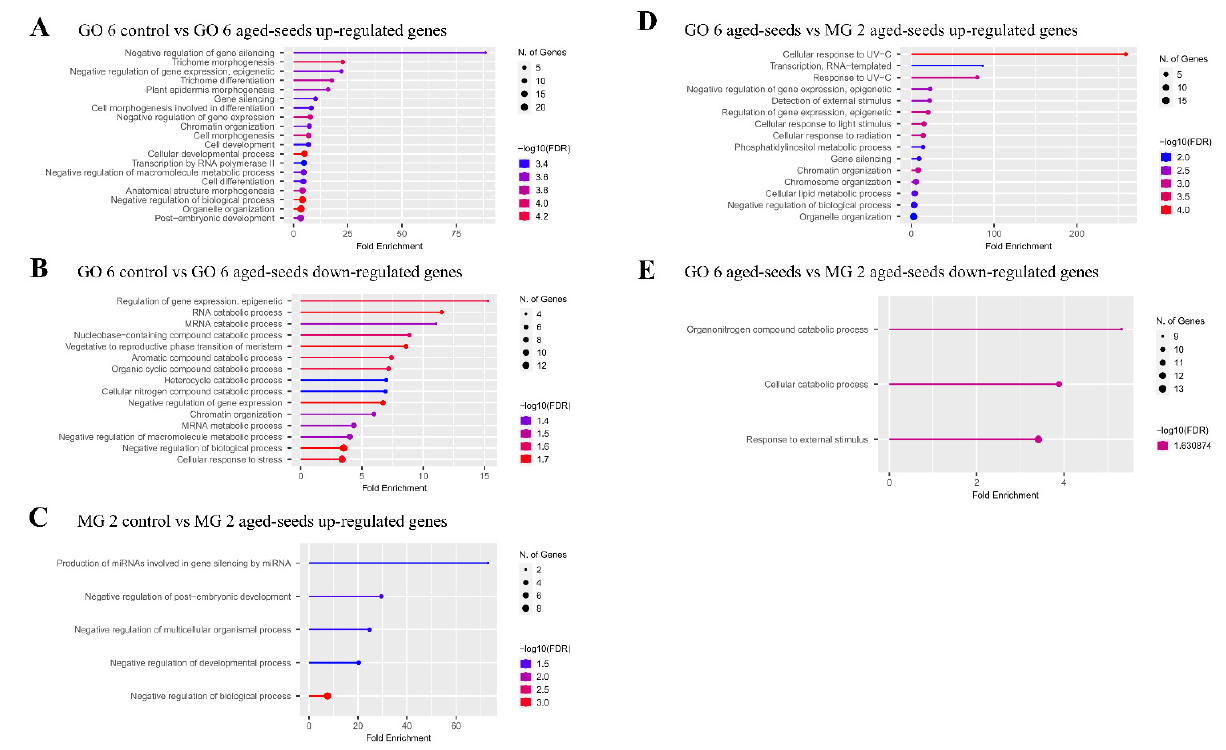
Figure 5. Gene Ontology (GO) enrichment analysis. ( A , B ) Enrichment analysis of DEGs that were up and down expressed in the comparison of GOIAS control vs. GOIAS aged-seeds. ( C ) Enrichment analysis of DEGs that were up expressed in the comparison of MINAS control vs. MINAS aged-seeds. ( D , E ) Enrichment analysis of DEGs that were up and down expressed in the comparison of GOIAS aged-seeds vs. MINAS aged-seeds.